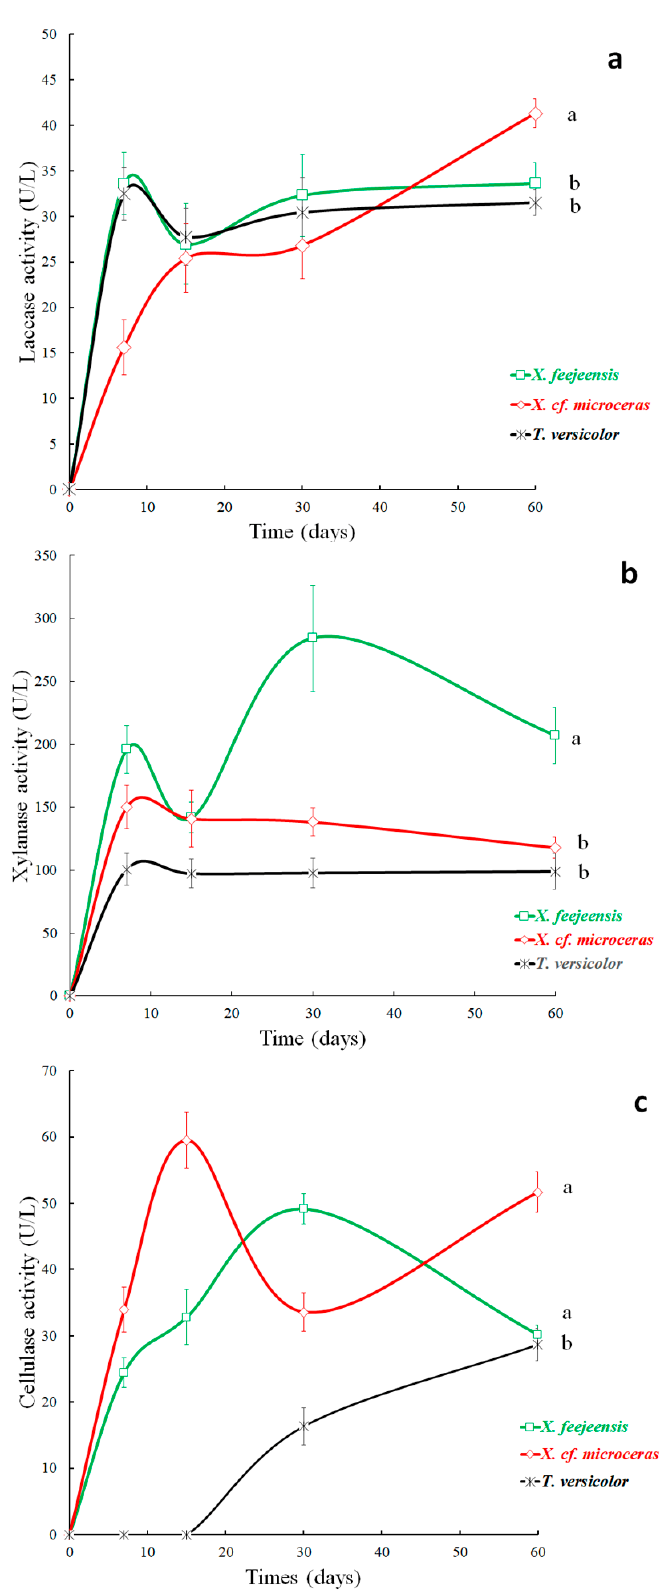
Figure 4. Laccase ( a ), xylanase ( b ) and cellulase ( c ) activities in BGR’s with native species of Xylaria spp. and T. versicolor incubated at 25 °C. The bars show the standard error of the mean measured activity of the four samples analyzed on each sampling day. Different letters indicate significant difference ( p ≤ 0.05%, HSD Tukey).